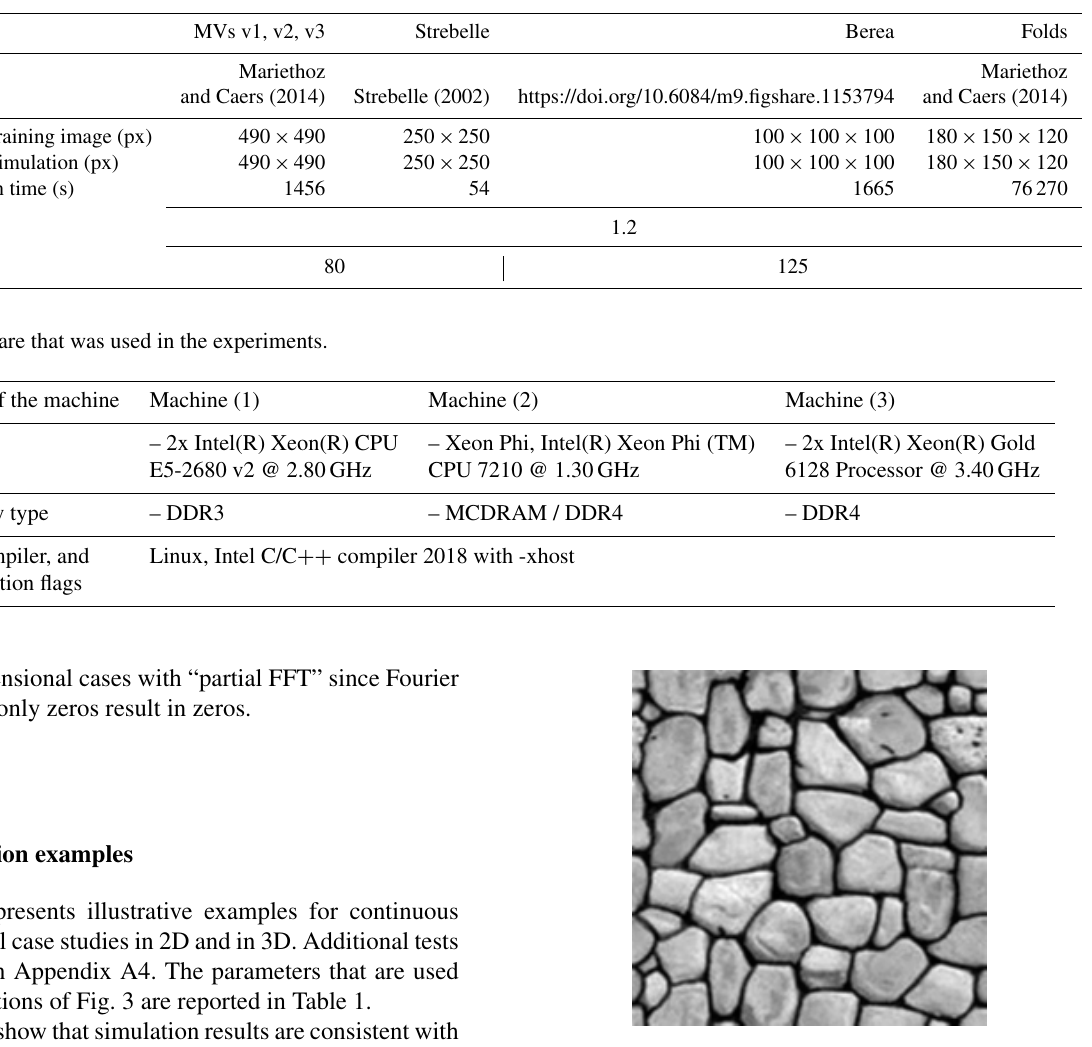
Table 1. Parameters that were used for the simulations in Fig. 3. Times are specified for simulations without parallelization. MVs represents multivariates.